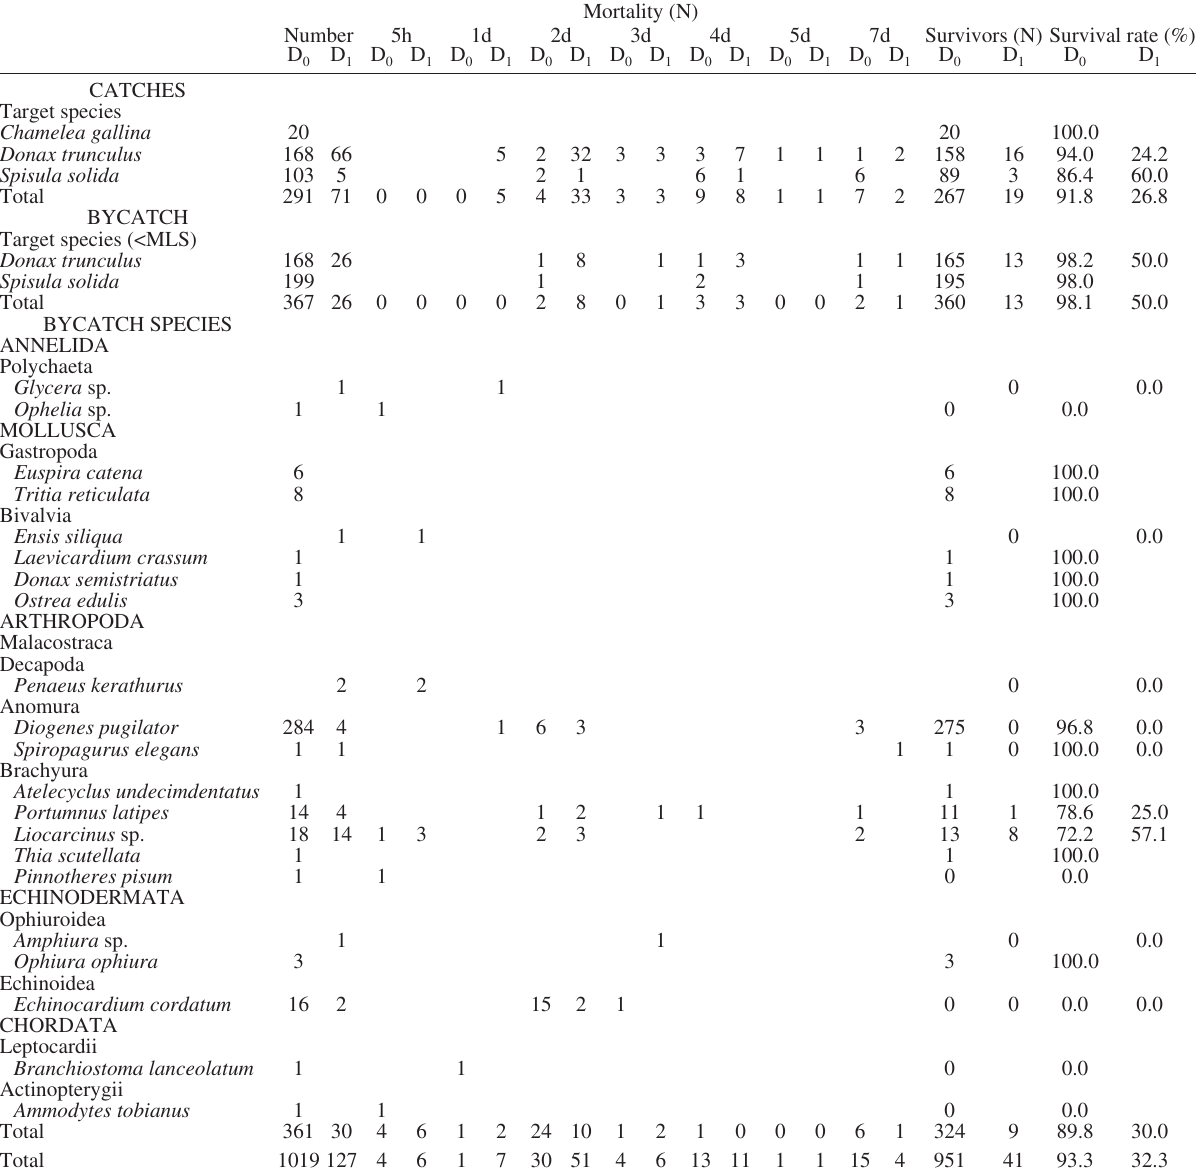
Table 6. – Survival experiments performed in the containment facilities with diverse taxa caught as target or bycatch species during bivalve